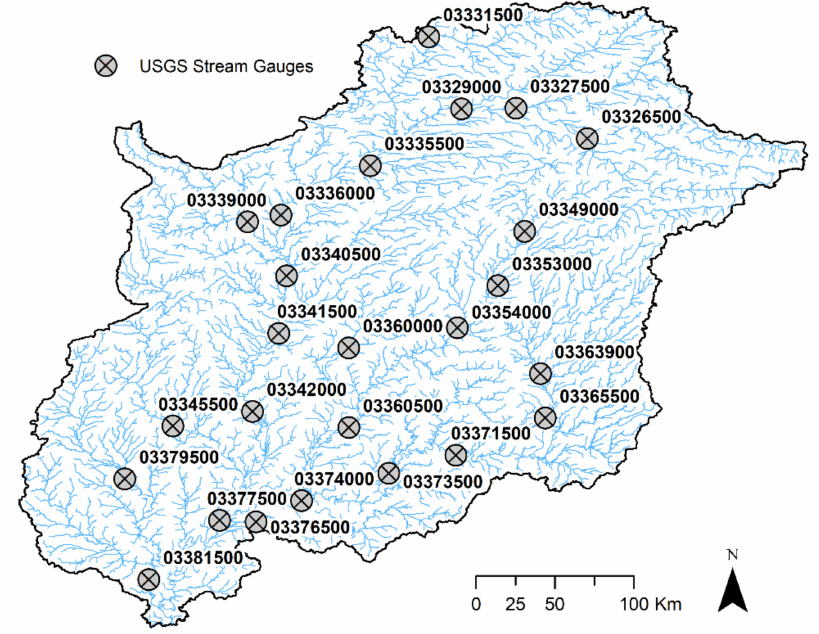
Figure 2. United States Geological Survey (USGS) gauging stations used for model